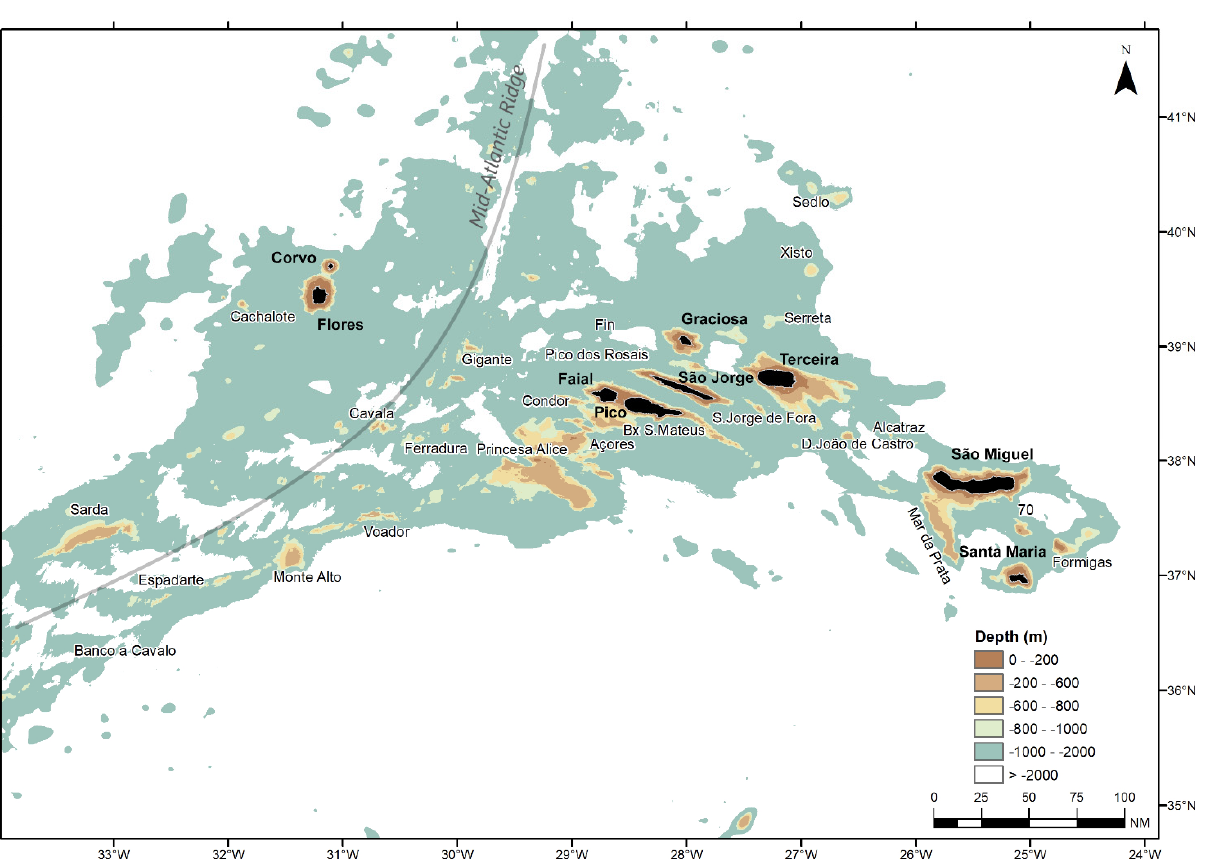
Figure 1. Location of the Azores archipelago (NE Atlantic Ocean), with the names of the nine islands (Corvo, Flores, Faial, Pico, S ã o Jorge, Graciosa, Terceira, S ã o Miguel, and Santa Maria) and main banks and seamounts. The approximate location of the Mid-Atlantic Ridge is shown as a light gray